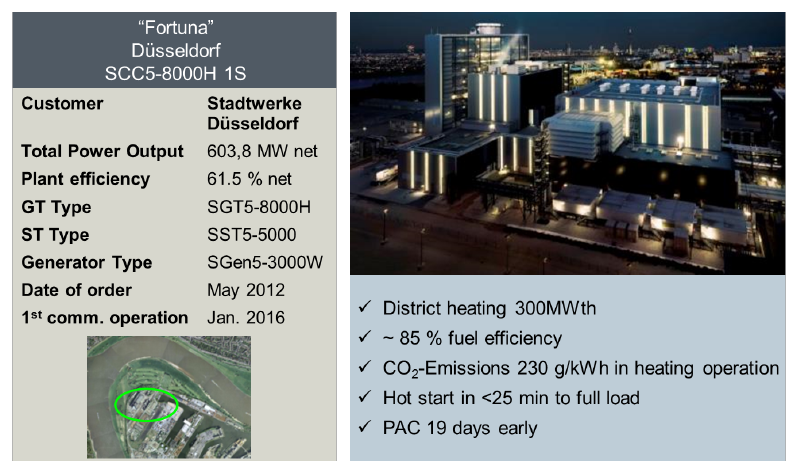
Figure 9. Fortuna Power Station, Düsseldorf, Germany.